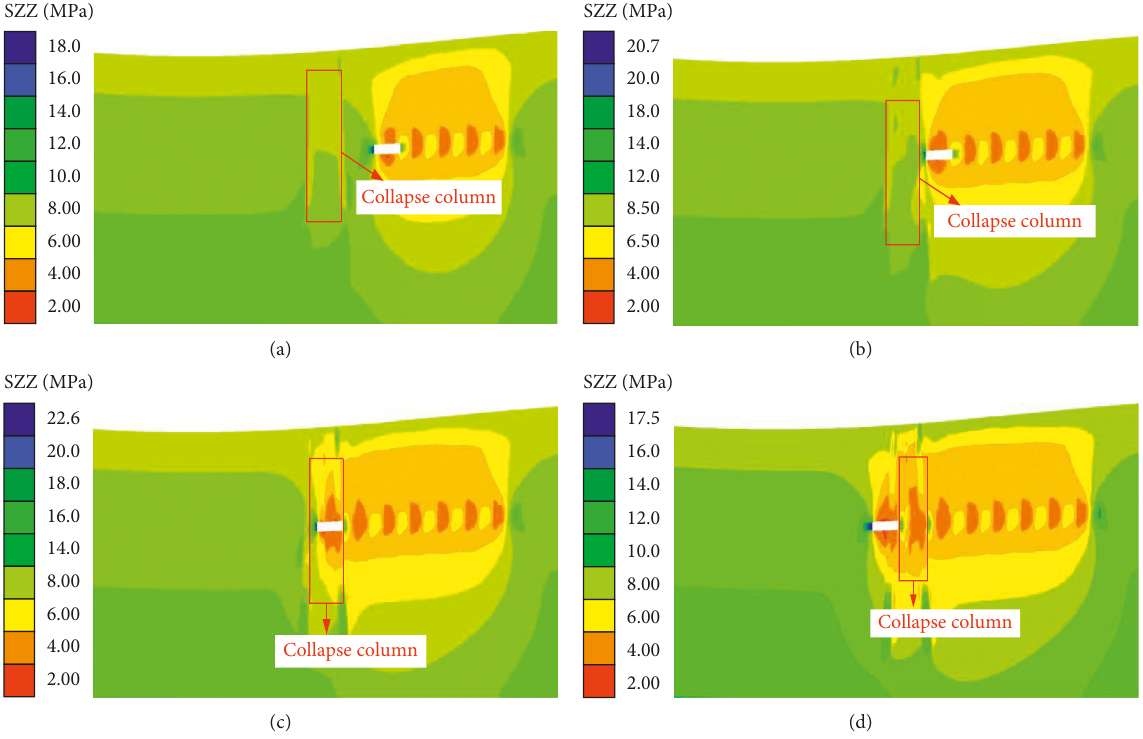
Figure 4: Vertical stress nephogram of the process in the working face: (a) working face 25m ahead of the collapse column, (b) working face 5m ahead of the collapse column, (c) working face above the collapse column, and (d) working face 10 m behind the collapse